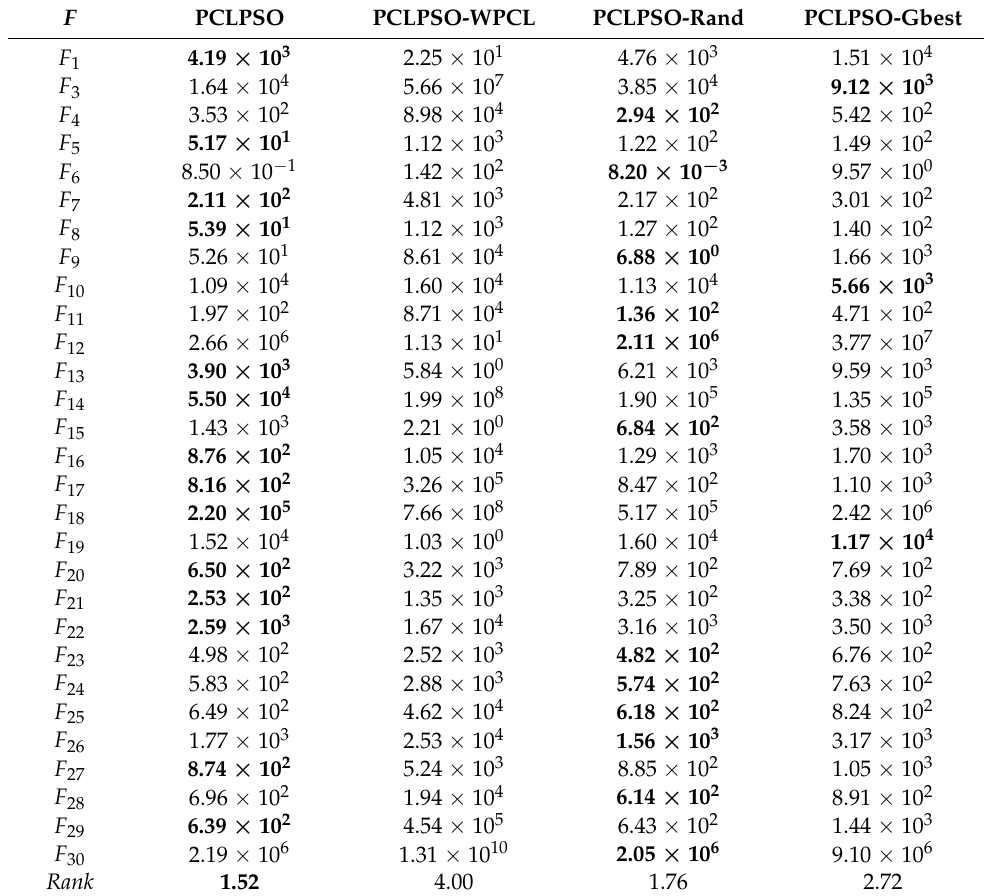
Table 7. Comparison results between PCLPSO with different learning strategies on 50- D CEC 2017 benchmark